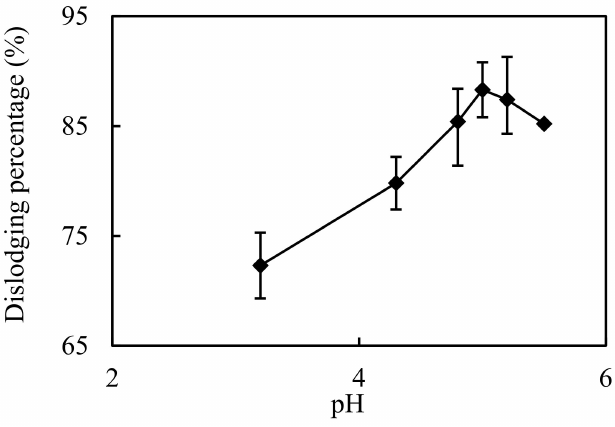
Figure 6. Impact of pH in the complemental feeding stage on dislodging of